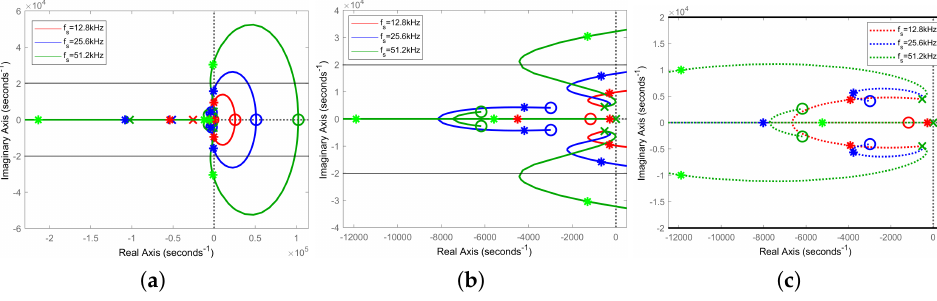
Figure 12. Root loci for the no-load system. Crosses—open loop poles, circles—zeros, dots—closed loop poles under assumption ∆ A = 1.1. The gains are as follows: f s = 12.8 kHz: k = 9, f s = 25.6 kHz: k = 35; f s = 51.2 kHz: k = 144 ( a ) general view ( b ) dominant poles (zoom), ( c ) system with no-delay controller C ∗ ( s ) (zoom). Notice a large impact of delays on the position of